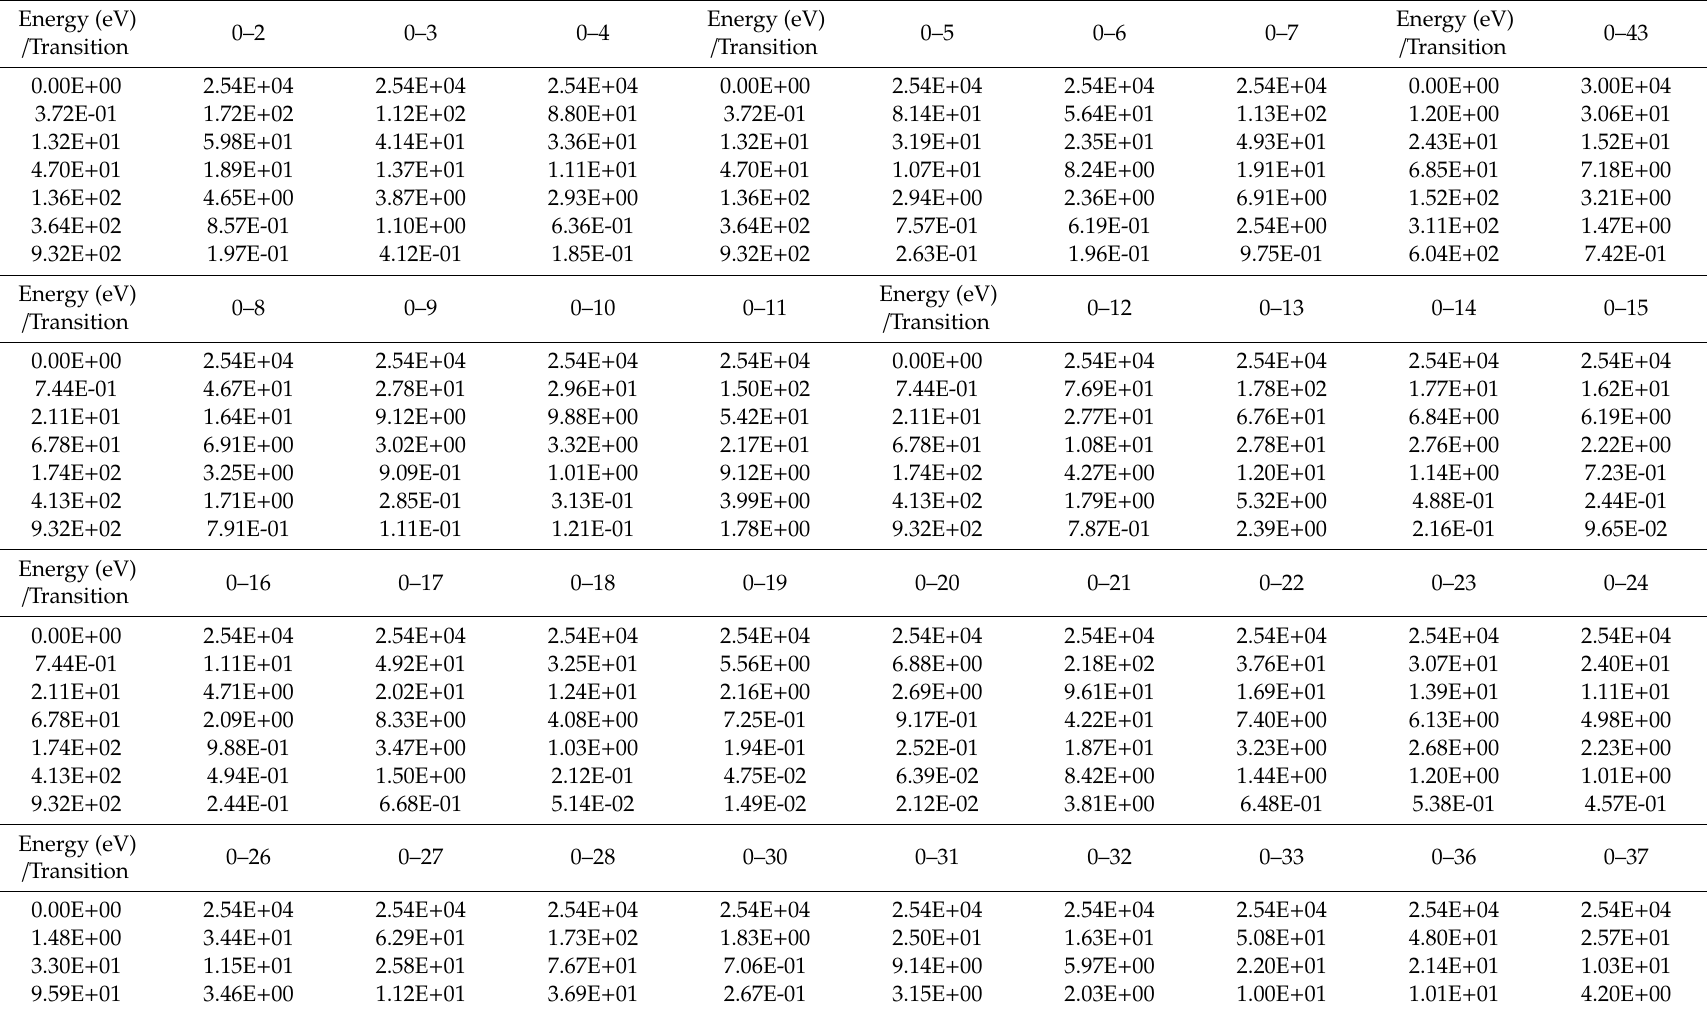
Table 15. Collisional excitation cross-sections (100 Mb) of Pm-like W from the ground state to various